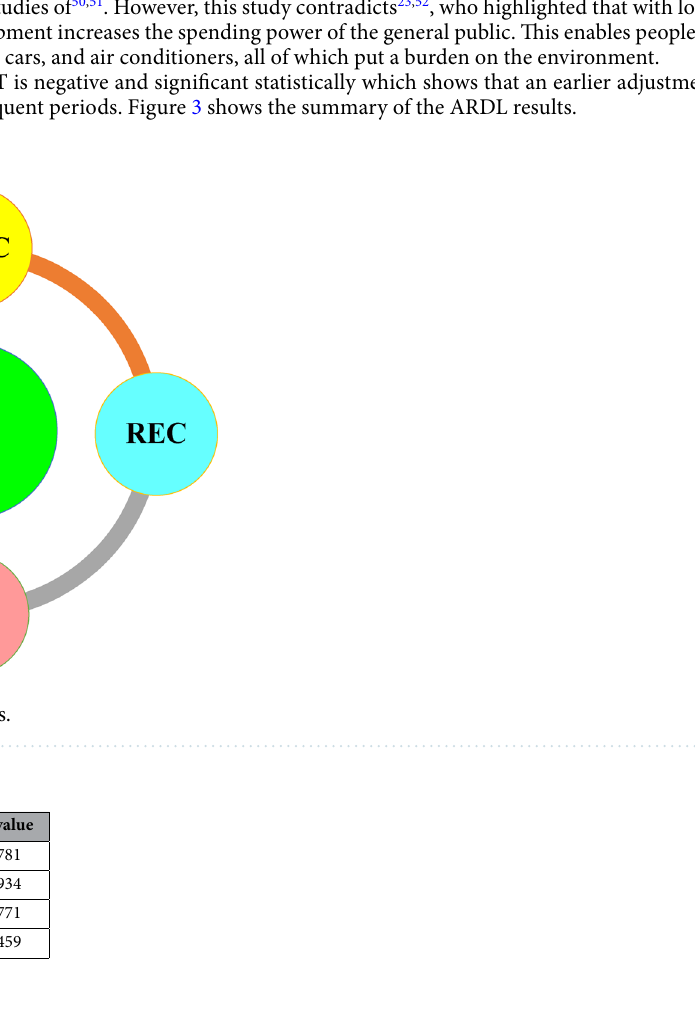
Table 7. Diagnostics